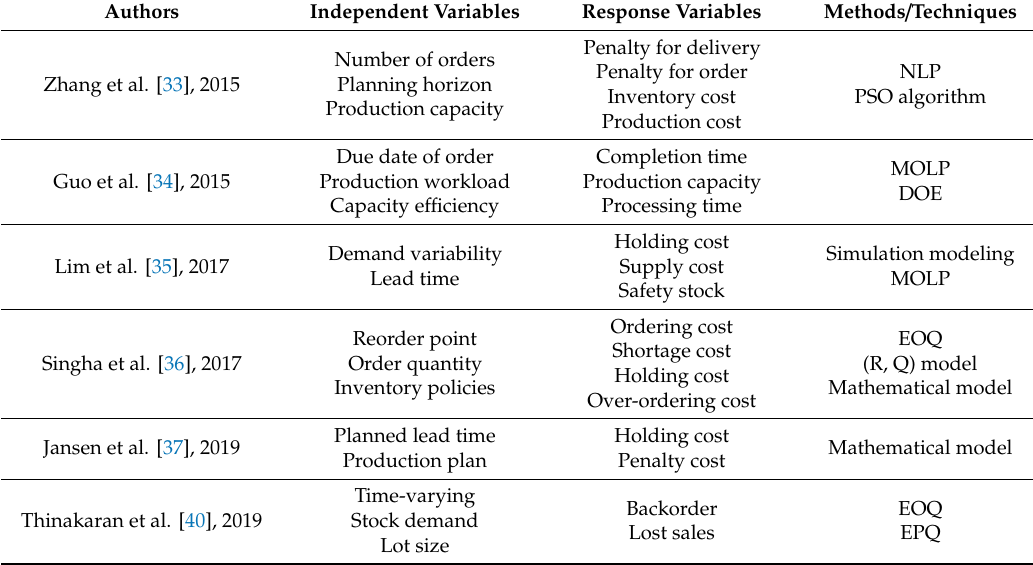
Table 1. List of common problem characteristics for several previous